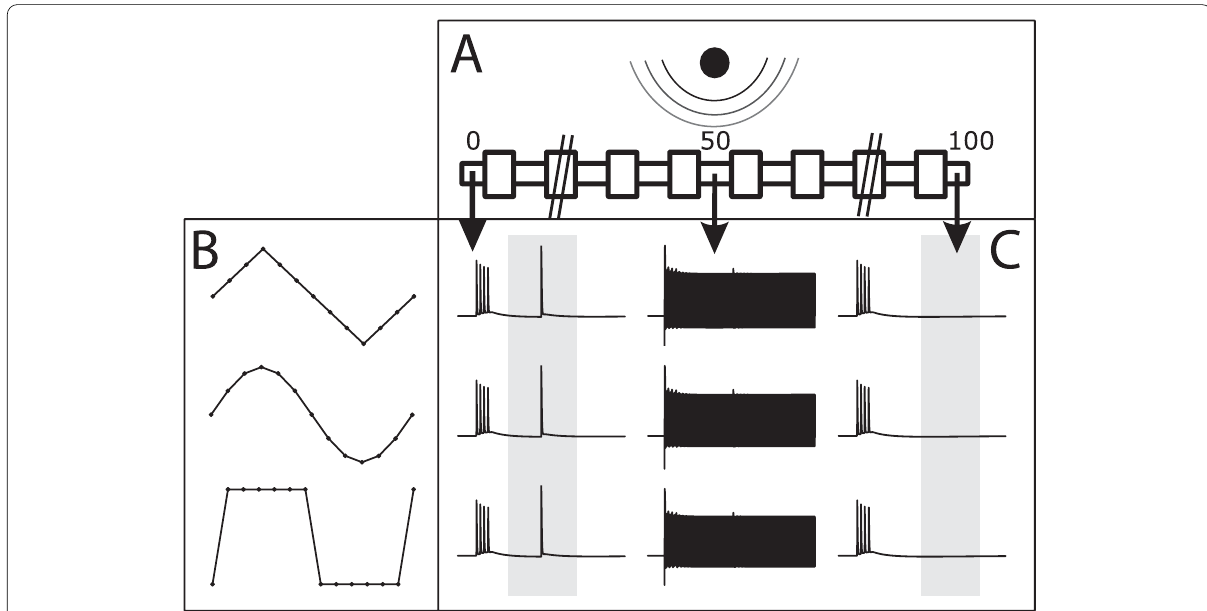
Fig. 1 The simulation environment is setup with a point source electrode 1 mm from a 101 node axon (shown in subfigure A ). The three tested waveforms are shown in subfigure B with their 1/12 period discretization. Each waveform was able to achieve block at varying amplitudes, and is shown in voltage plots in subfigure ( C ). The left column of transmembrane voltage plots shows the voltage of node 0 over time with a test pulse sent as seen in the blue indicator box. The center column shows the voltage over time of the central node (node 50). The right column shows the voltage of node 100 over time and the red indicator box showing where no action potentials are seen, indicating that the test pulse was successfully